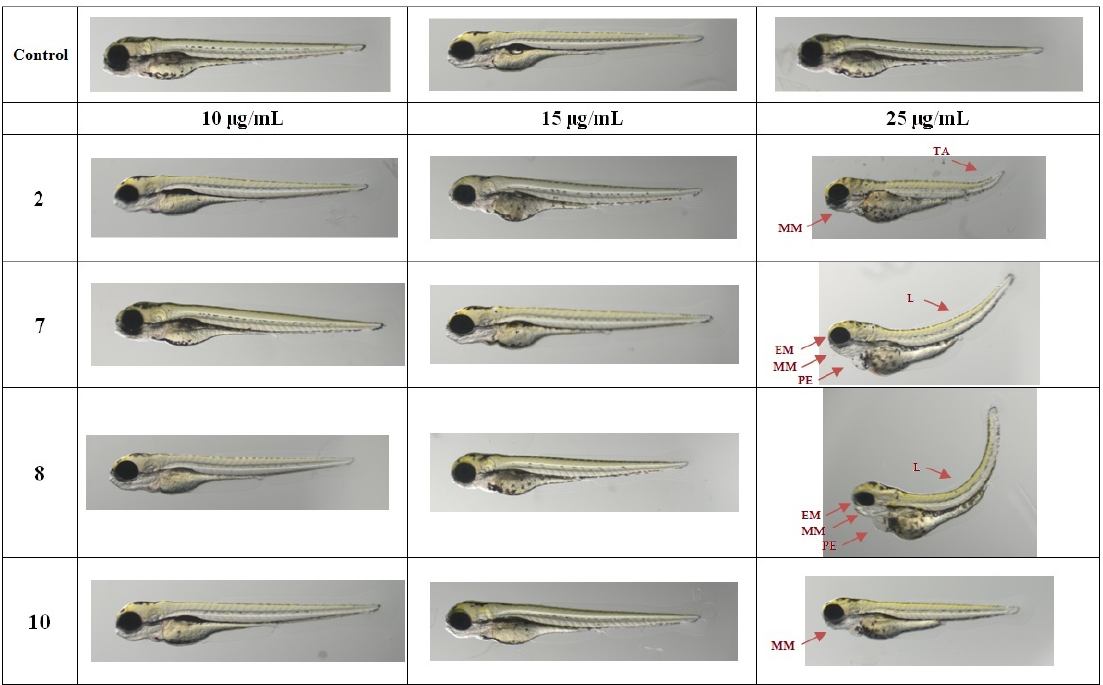
Figure 5. Effects of the investigated TZD hybrid molecules 2 , 7 , 8 , and 10 on zebrafish after 96 h of exposure. Representative morphological alterations in 96 hpf larvae are indicated by arrows. EM— eye malformations; HM—head malformations; MM—mandibular malformations; PE—pericardial edema; L—lordosis; TM—tail malformations.